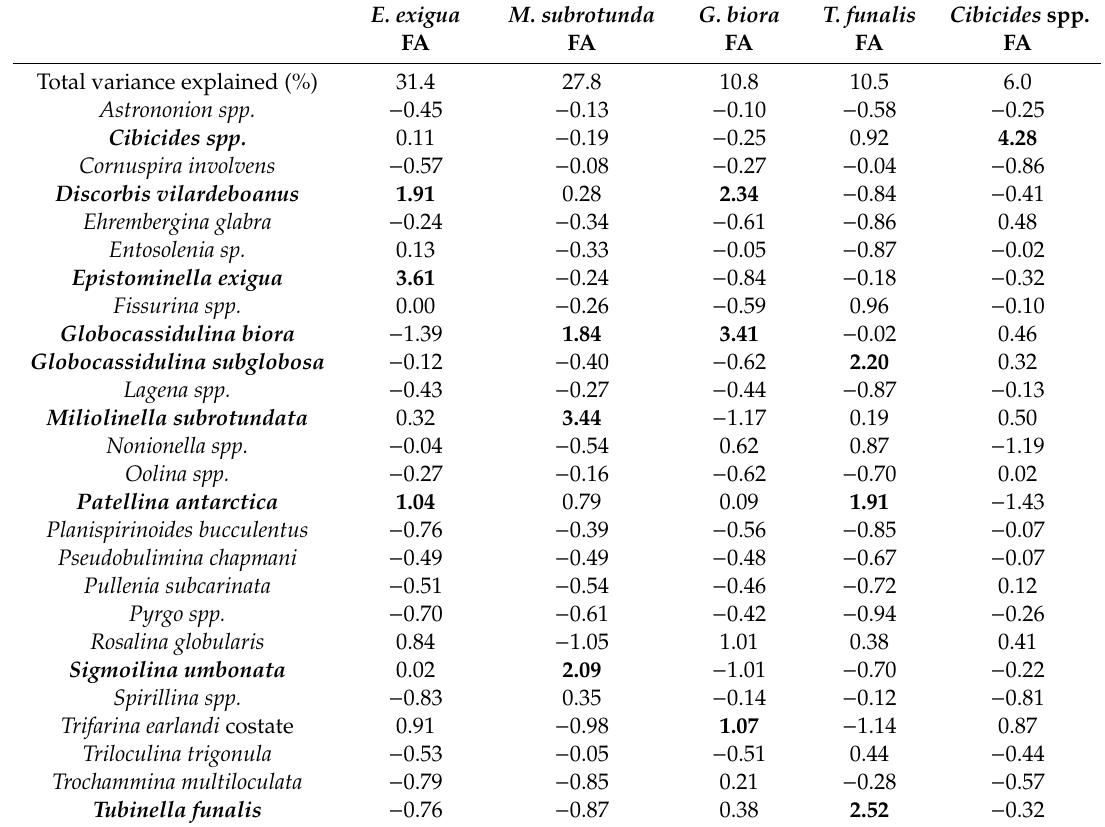
Table 2. Foraminifer Principal Component scores (FAs). The dominant species for particular FA are reported in